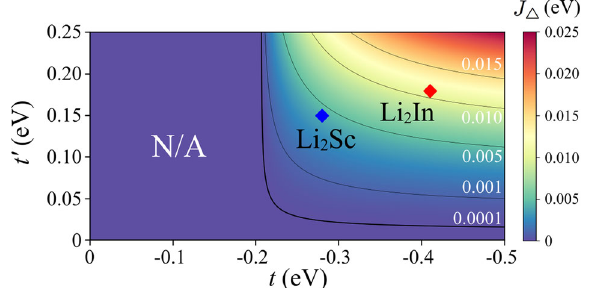
Fig. 6 Exchange interaction for the spin model in a cluster Mott insulator regime. Exchange coupling J 4 calculated from Eq. (4) with U = 2.0 eV, V = 1.1 eV and V 0 ¼ 0 : 9 eV. Li 2 ScMo 3 O 8 and Li 2 InMo 3 O 8 are shown with